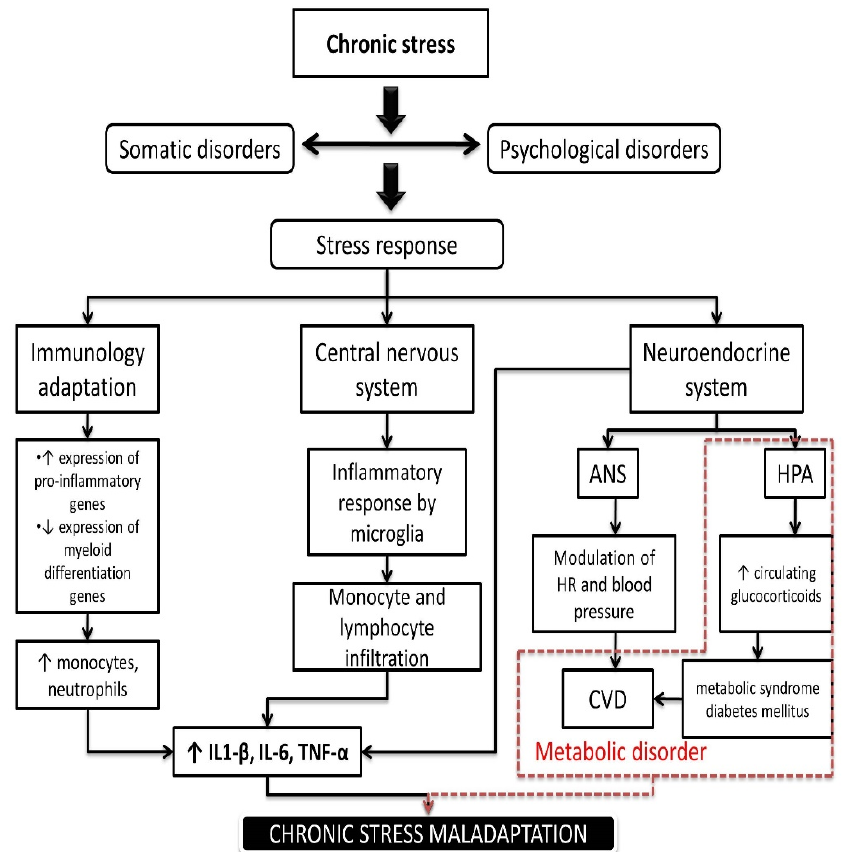
Figure 2. Pathophysiological complexity and mechanism of stress vulnerability. Abbreviations; IL- 1 β —interleukin-1- β ; IL-6—interleukin 6; TNF- α - tumor necrosis factor alpha; HPA—hypothalamic- pituitary adrenal axis; ANS—autonomic nervous system; CVD—cardiovascular diseases.